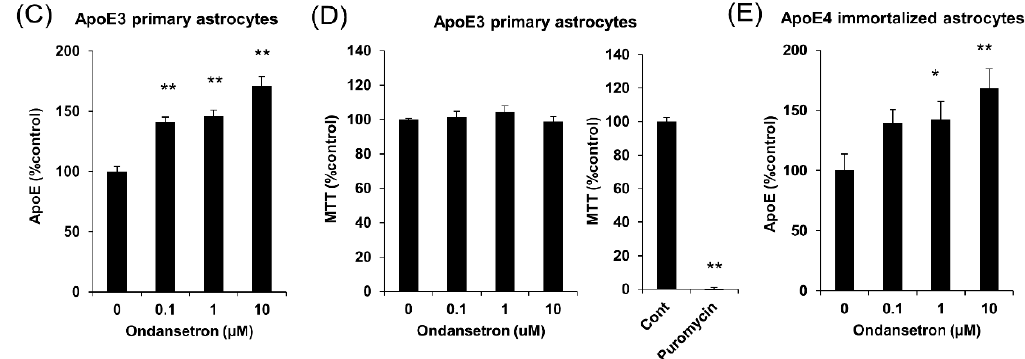
Figure 1. OS increases apoE secretion in immortalized astrocytes or primary astrocytes derived from apoE3-TR mice and apoE4-TR mice. ( A , B ) Immortalized astrocytes derived from apoE3-TR mice were cultured and treated with the indicated concentrations of OS. After treatment with OS for 24 h, apoE levels in culture media were determined by ELISA ( A ), and cell viability was assessed by MTT assay ( B , left). Puromycin treatment was used as a positive control for MTT assay ( B , right). ( C , D ) Primary astrocytes derived from apoE3-TR mice were cultured and treated with the indicated concentrations of OS. After treatment with OS for 24 h, apoE levels in culture media were determined by ELISA ( C ), and cell viability was assessed by MTT assay ( D , left). Puromycin treatment was used as a positive control for MTT assay ( D , right). apoE levels in culture media of immortalized astrocytes derived from apoE4-TR mice ( E ) were determined by ELISA after treatment with indicated concentrations of OS for 24 h. Data represent mean ± SD (( A , B ): n = 6, biological replicate group, ( C , D ): n = 3, biological replicate group). * p < 0.05, ** p < 0.01; Tukey-Kramer test.